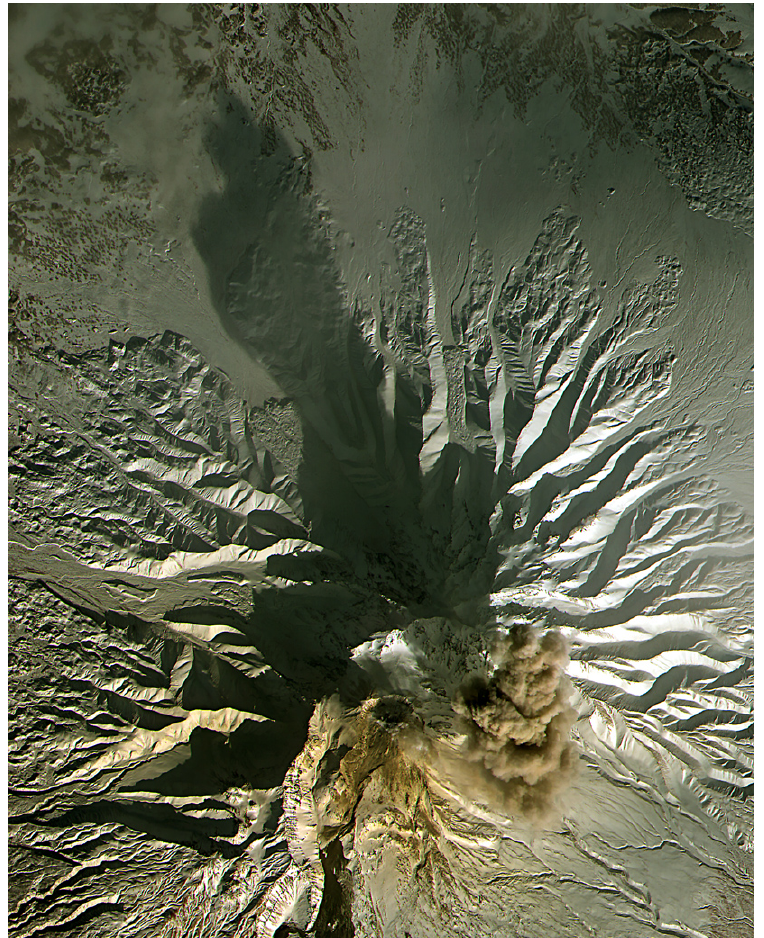
Figure 11. Detail of an scene by the Advanced Spaceborne Thermal Emission and Reflection Ra- diometer (ASTER) acquired on 17 February 2008. We applied the the shadow-height methodology to calculate the height and vertical velocity of an ash plume at Shiveluch Volcano in Kamchatka,